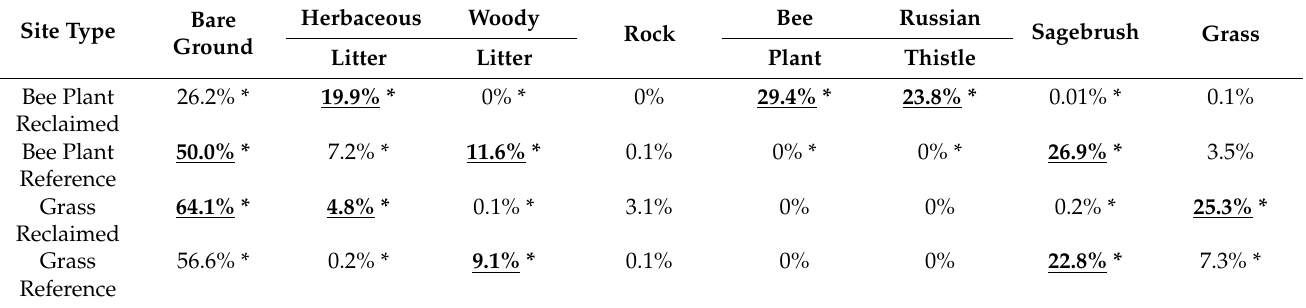
Table 1. Relative mean percent of sample point analysis in 2015. All site types had a total of 2880 secondary sampling units (pixels) analyzed, which are converted to percentages in this table. Reclaimed sites were compared directly to their paired adjacent reference sites. All sites were significantly different ( p < 0.001). Columns with * indicate those which were responsible for significant differences. Bolded and underlined numbers suggest higher proportion of that cover type within that site type compared to the paired reclamation or reference